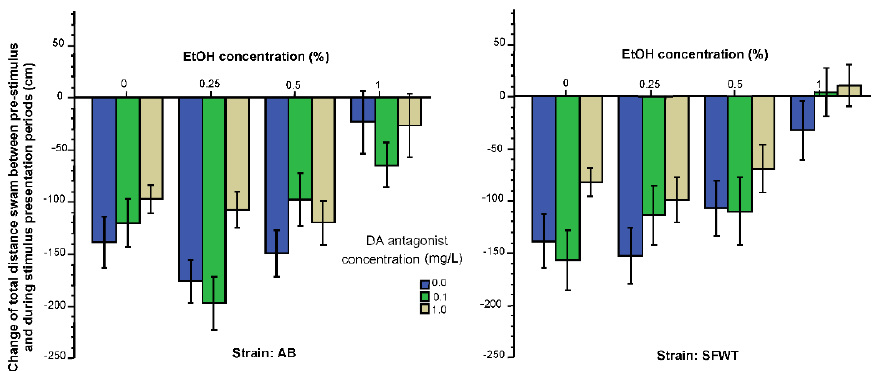
Figure 3. Change of total distance swum elicited by the presentation of animated conspecific images is influenced by the concentration of acute alcohol (X-axis) and the concentration of acute D1-R antagonist (legend) in an additive manner. Additionally, note the significant strain difference. Mean ± S.E.M. are shown.